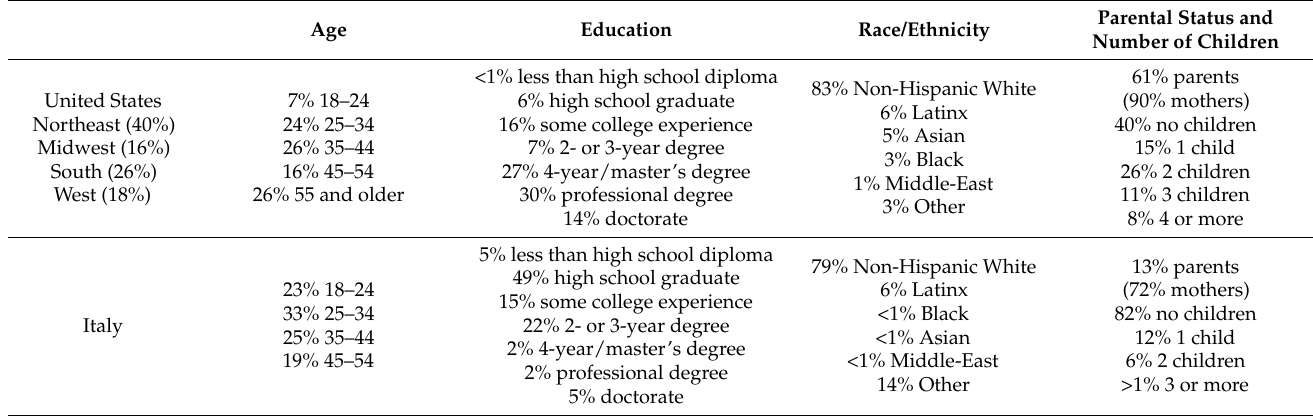
Parental Status and Number of Children